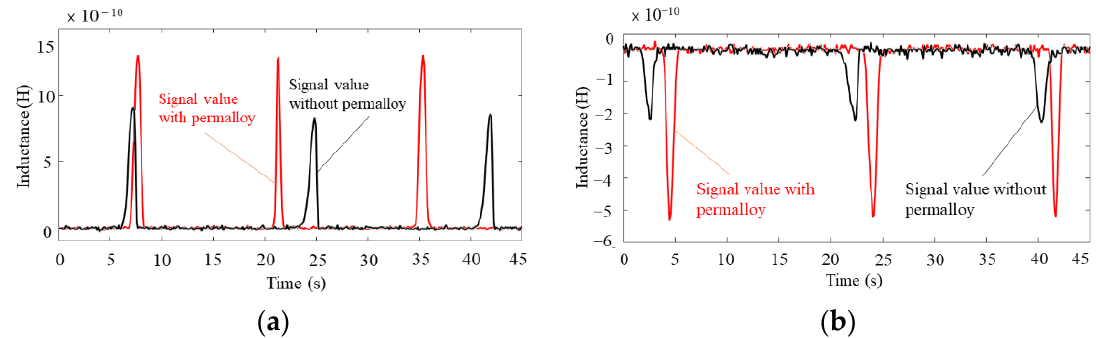
Figure 6. Waveform diagram of metal particle detection with or without permalloy package: ( a ) waveform plots for detecting 80–90 μ m iron particles, ( b ) waveform plots for detecting 140–150 μ m copper particles.